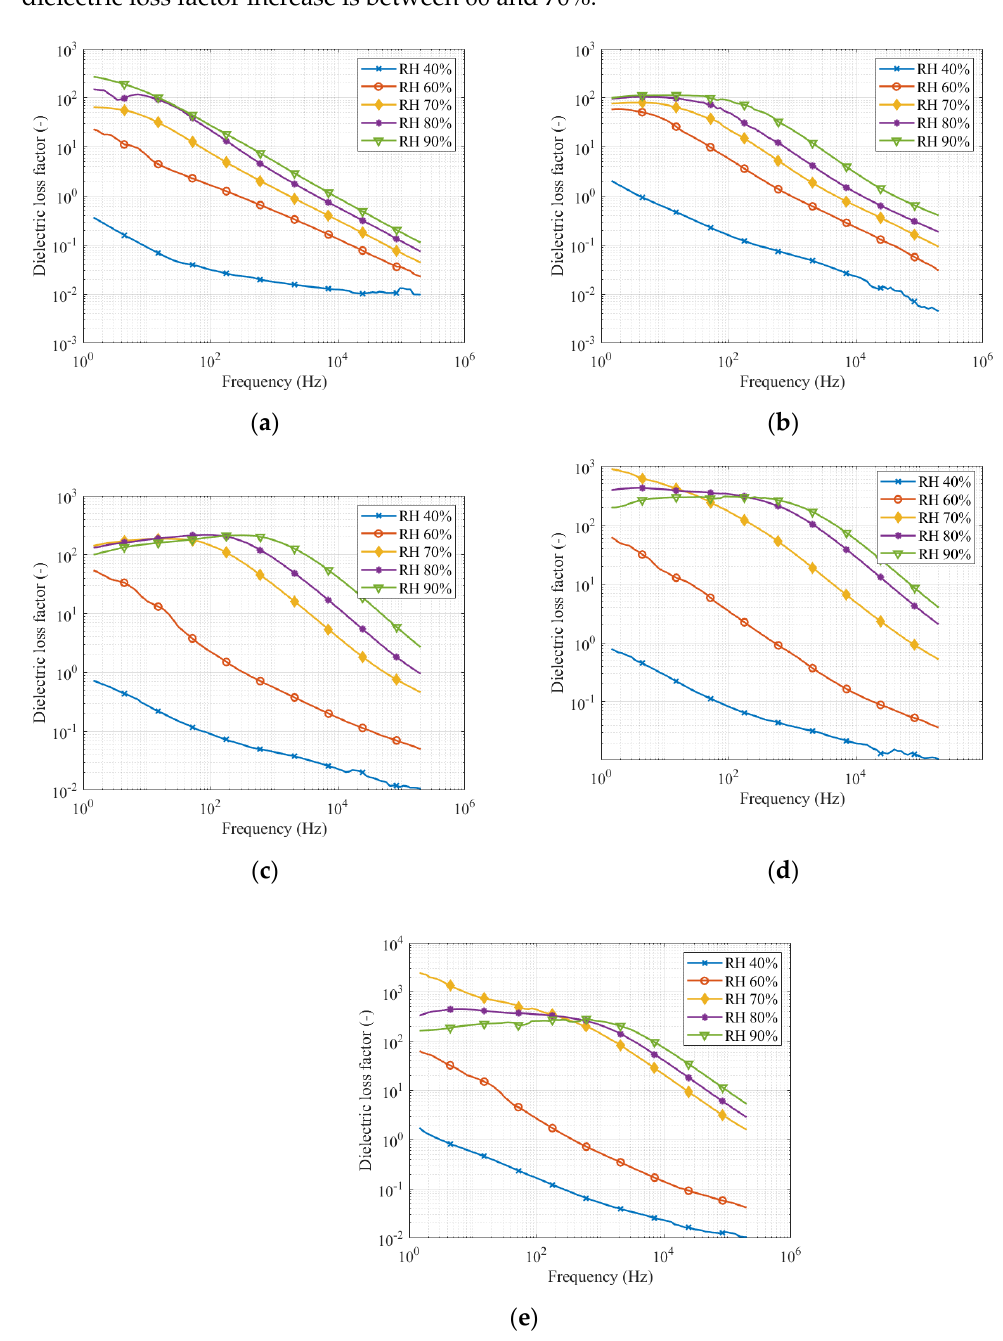
Figure 7. Dielectric loss factor in the frequency range: ( a ) clean insulator; ( b ) first pollution level; ( c ) second pollution level; ( d ) third pollution level; ( e ) fourth pollution level. The increase in dielectric loss factor between these two relative humidities is at a frequency of 1 kHz, from 51 times to 263 times higher for different pollution levels. For the fourth pollution level, the dielectric loss factor for 60% relative humidity is 0.48, and for relative humidity, 70% is